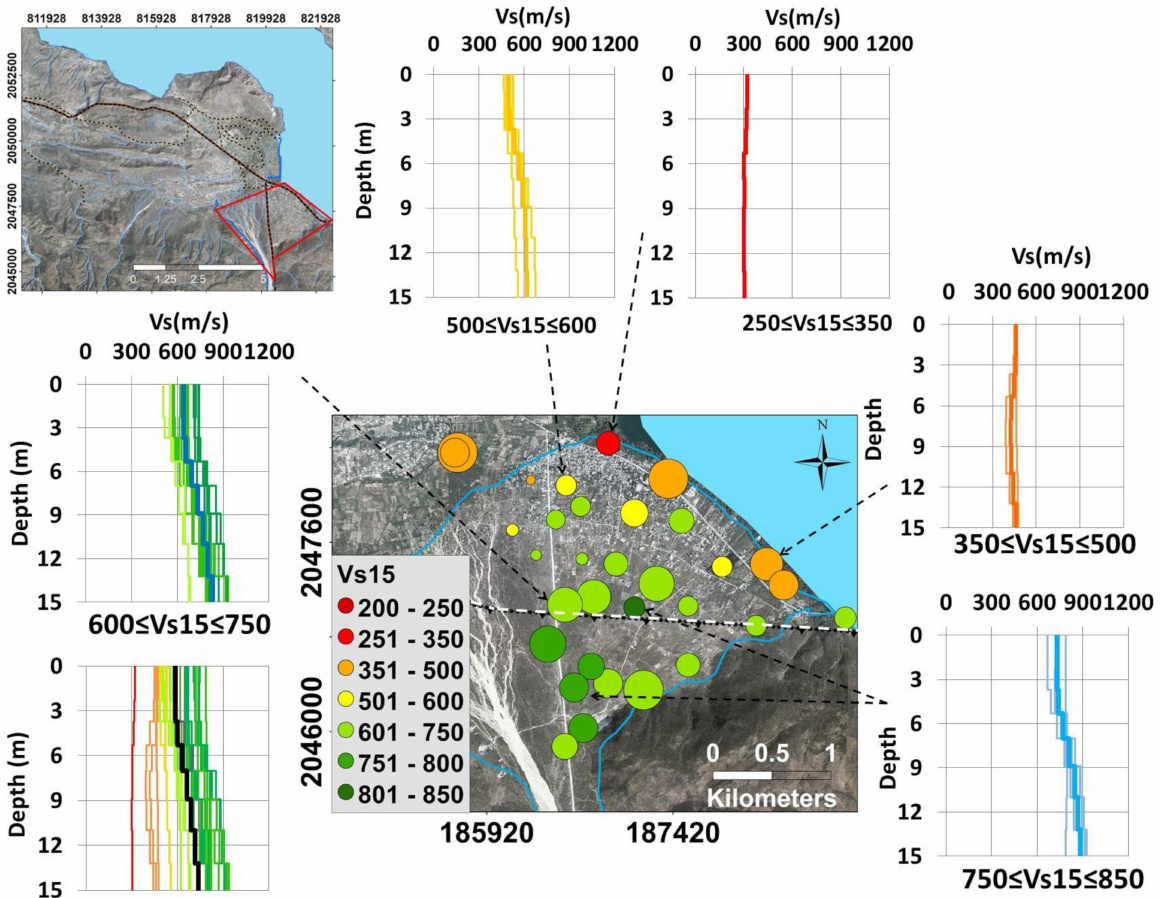
Figure 5. Vs profiles determined for the village “La Source” and the alluvial fan (down to a depth of 15 m). All profiles in this area are summarized in the lower left corner with an average Vs log of this area outlined in black. Average Vs15 values are represented in the central map by colors for each investigated site. See also the approximate location of the EPG